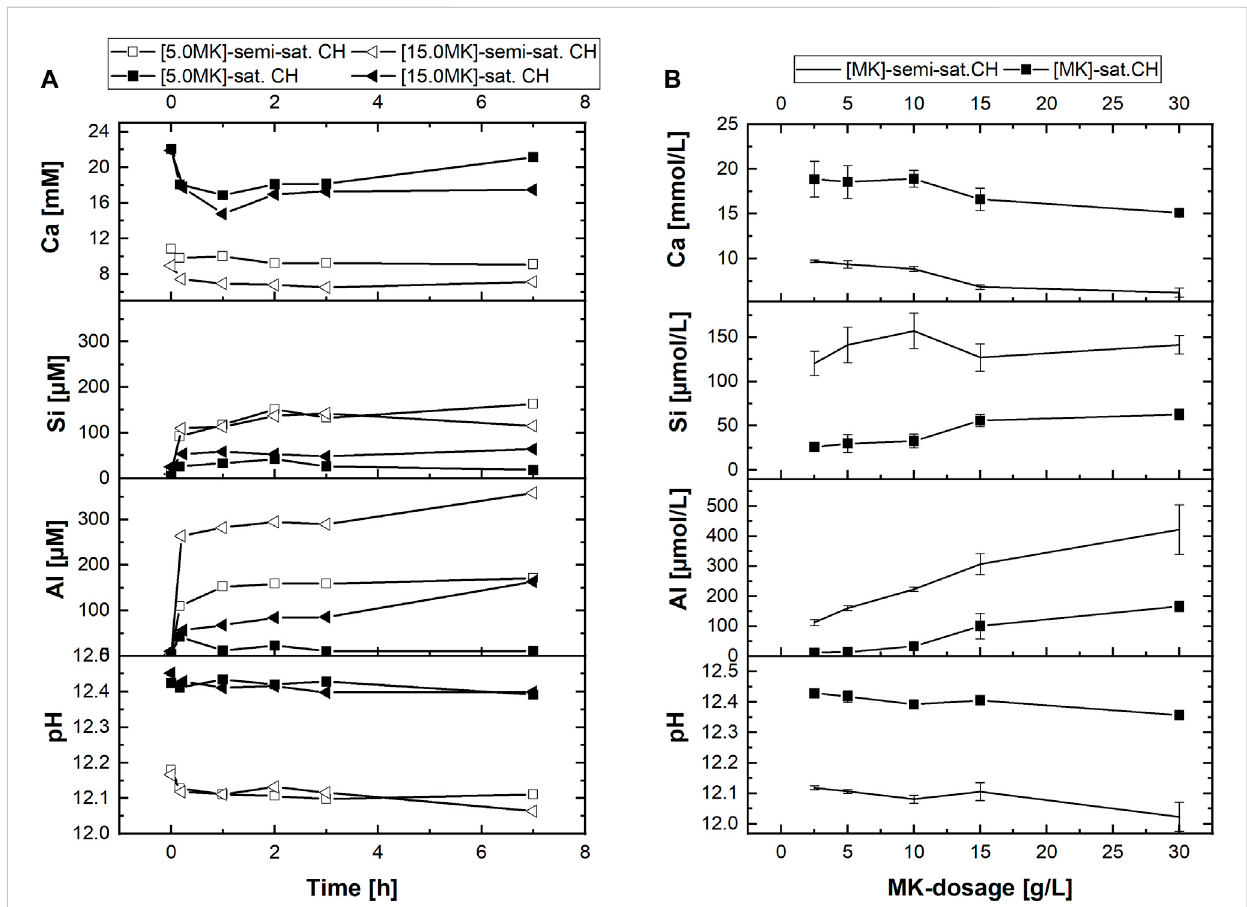
Calcium, silicate and aluminate concentrations as well as pH of the aqueous phase during reaction of MK in fi ltered semi- and saturated